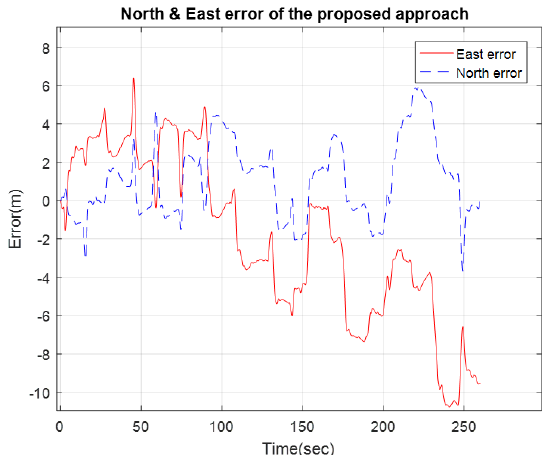
Figure 20. Errors in the north and east direction of the proposed approach integrated with INS during 260 Secs of GNSS signal